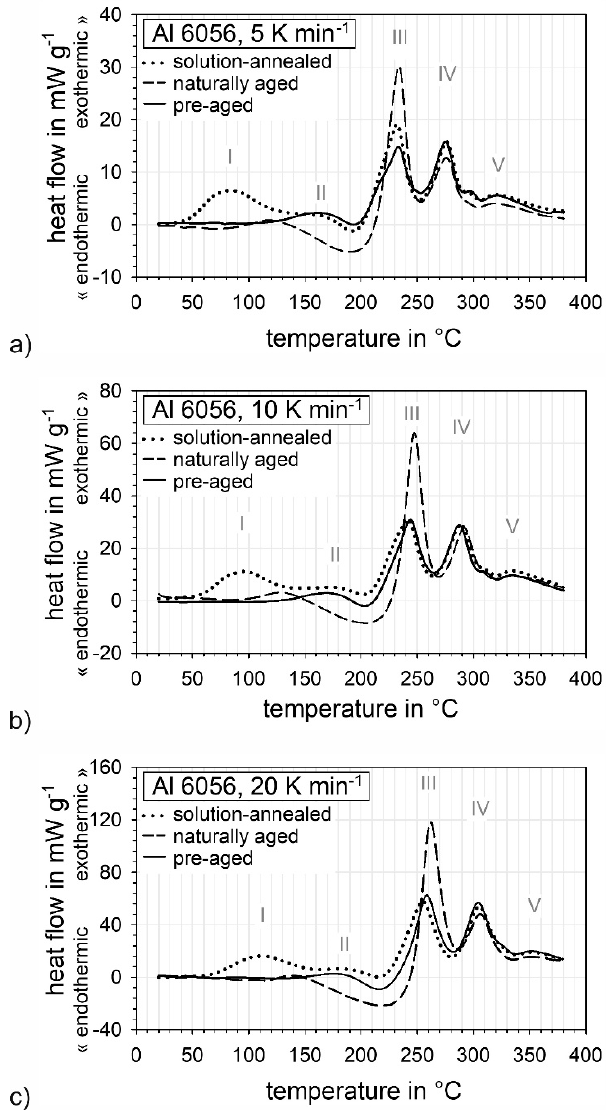
Figure 1. Differential scanning calorimetry (DSC) thermograms for the 6056 aluminum alloy in solution-annealed, naturally-aged and pre-aged conditions obtained for the following three heating rates: ( a ) 5 K min − 1 , ( b ) 10 K min − 1 and ( c ) 20 K min − 1 . With an increased heating rate, the peaks shift towards higher temperatures. After pre-aging at 80 °C, the formation of Mg-Si co-clusters (peak I) is not observed in the thermograms. The naturally-aged condition shows a pronounced endothermic peak, which corresponds to the dissolution of the Mg-Si co-clusters.